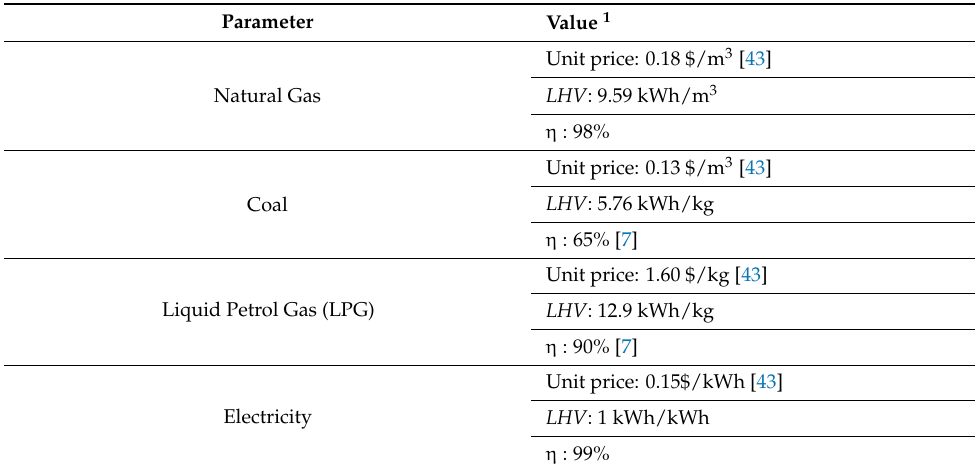
Table 3. Parameters for the financial